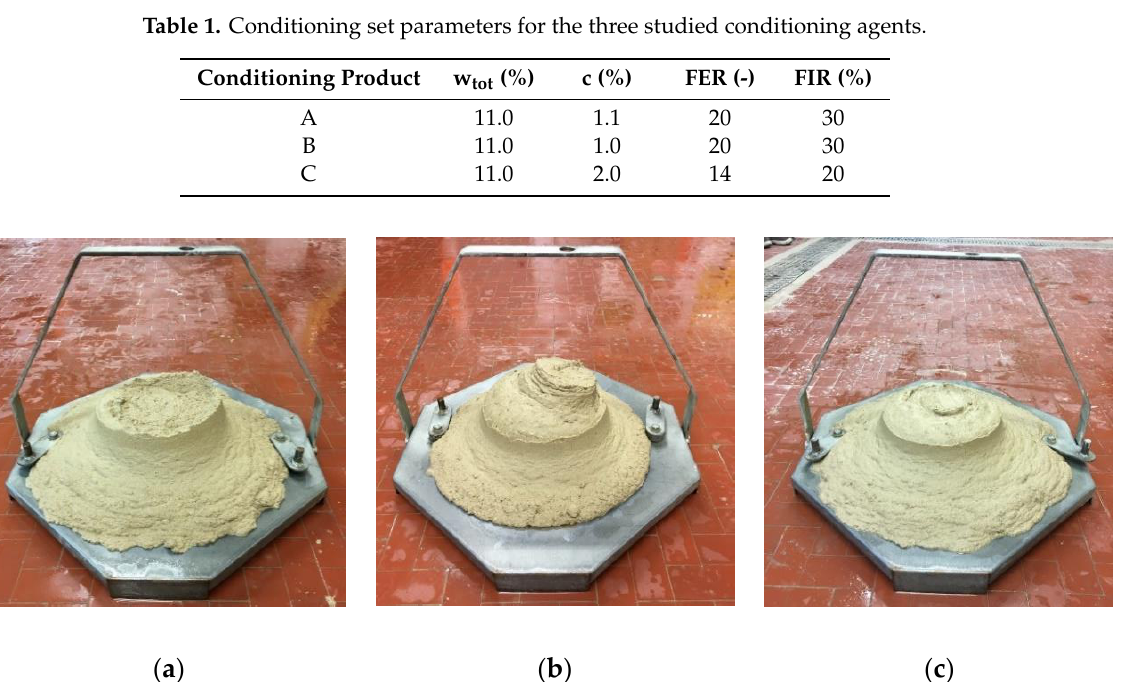
Figure 3. Picture of the slump test for the three tested products ( a ) Product A; ( b ) Product B; and ( c ) Product C.